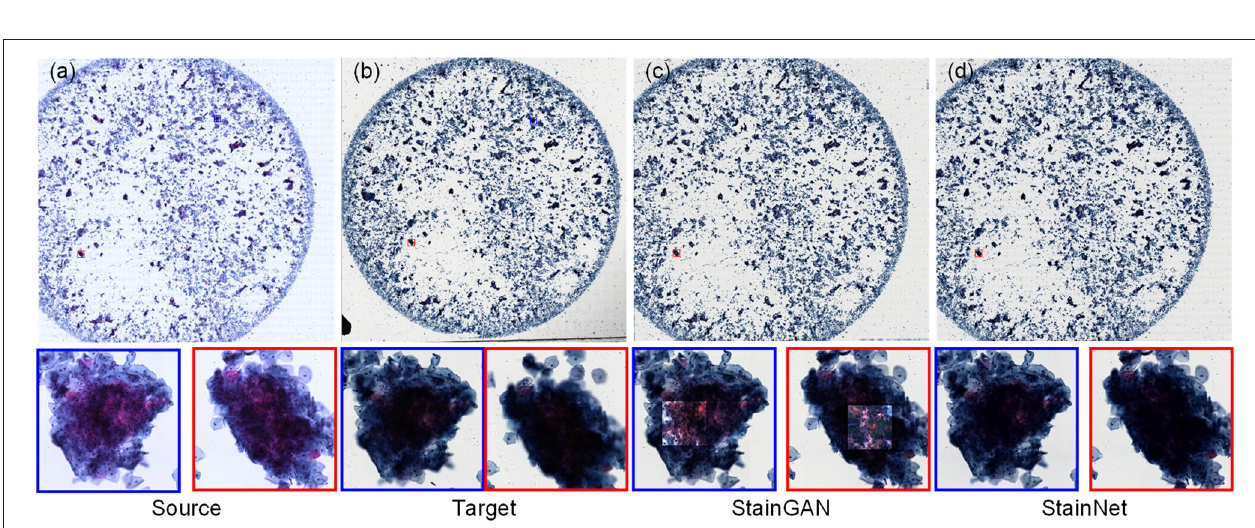
FIGURE 6 | The whole slide image normalization result on the cytopathology dataset. The source slide (a) , the target slide (b) , the normalized slide by StainGAN (c) , and the normalized slide by StainNet (d) are listed.